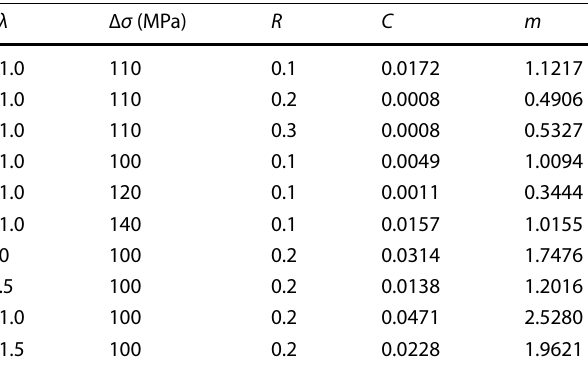
Table 3 Fitting results of relationship between d a /d N and Δ